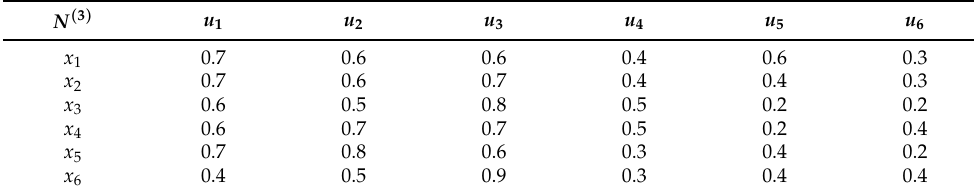
Table 8. Normalized decision matrix of expert e 3 .